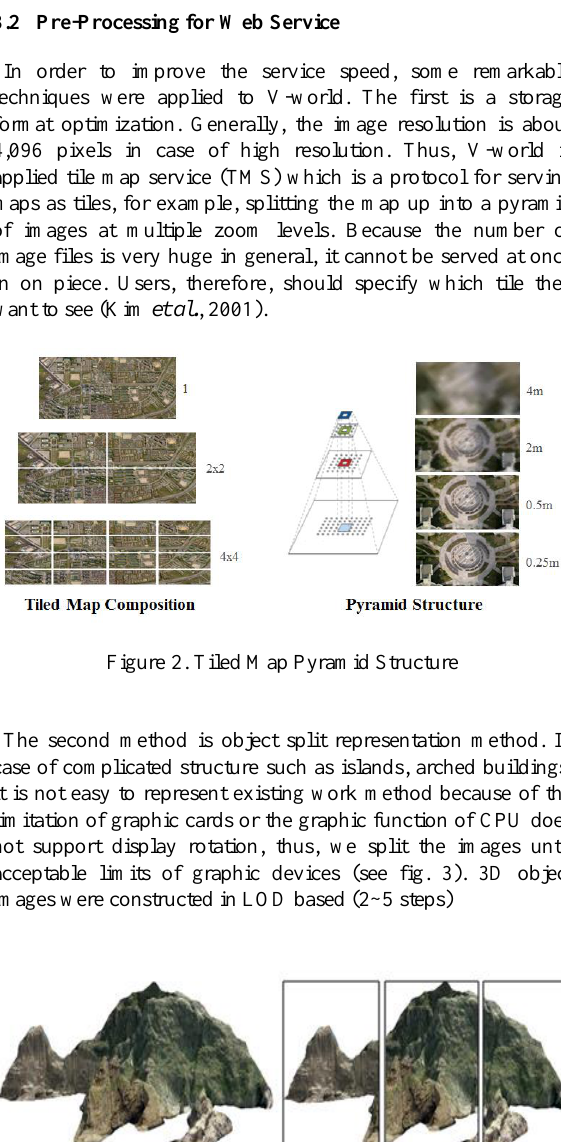
Table 1. Standard Dataset of Korea